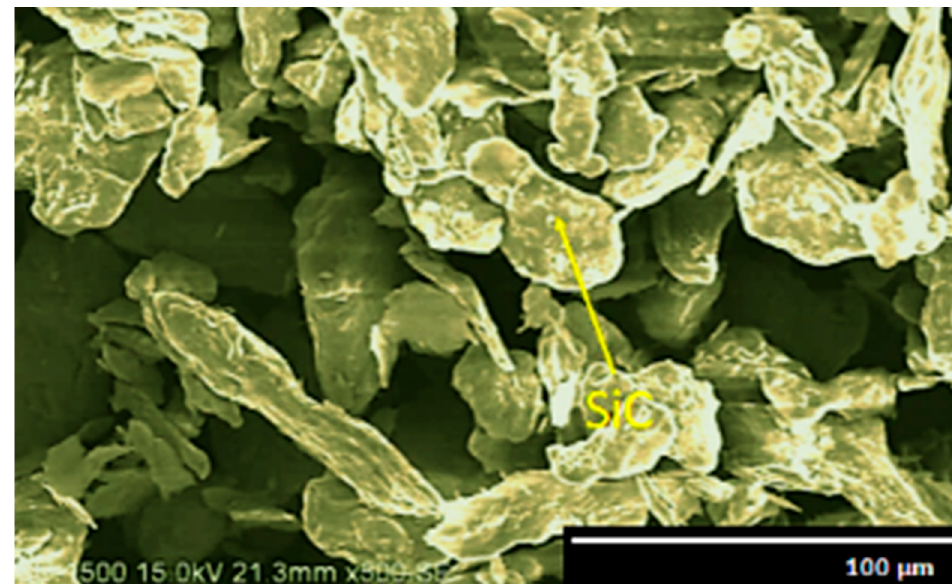
Figure 1. SEM of fly ash flakes at 500× magnification.